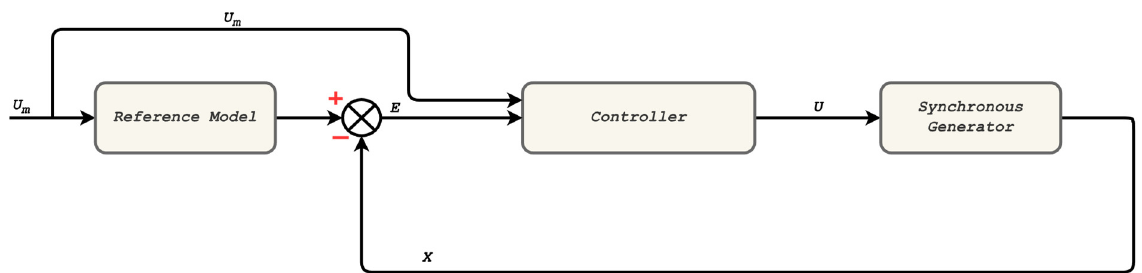
Figure 1. Proposed Lyapunov-based architecture. where u m ∈ R m is the reference model’s control vector input, u ∈ R m the controller’s output, and e ∈ R n the error between the desired and the generator’s state vectors.